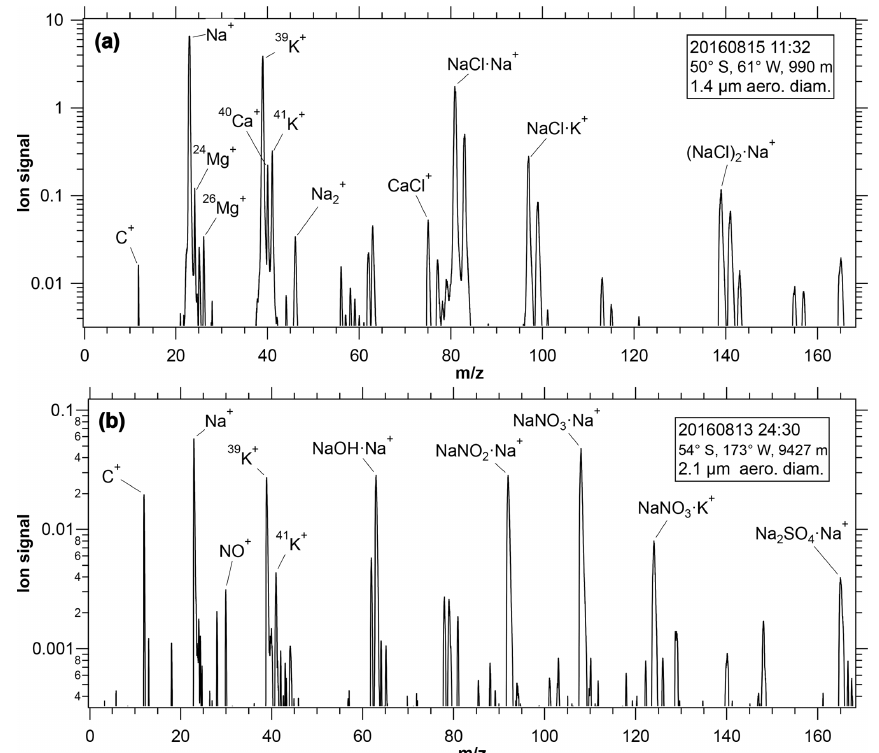
Figure 1. Mass spectra of (a) a typical sea-salt particle and (b) a highly processed sea-salt particle where the chloride has been replaced by nitrate and sulfate. The spectrum in panel (a) is chosen to be similar to the average of all low-altitude spectra of sea